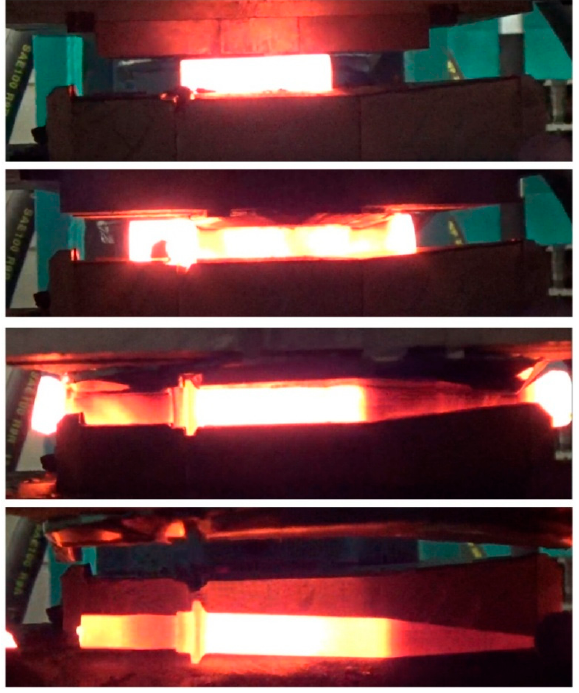
Figure 4. The cross-wedge rolling (CWR) process of the harrow tooth preform conducted in laboratory conditions in the Lublin University of Technology.